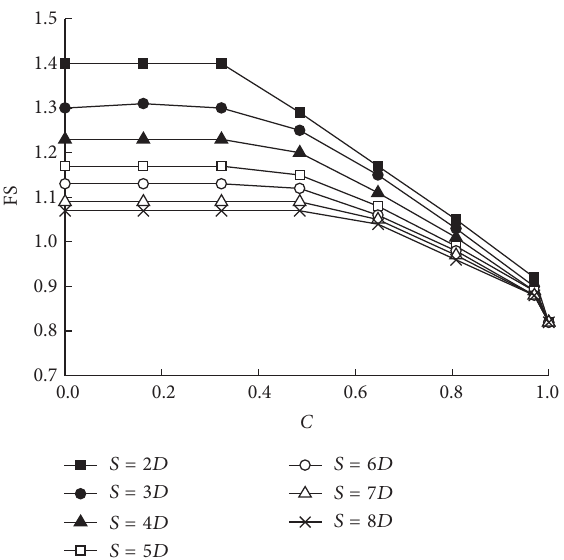
Figure 20: FS values of the piled slopes for Model B ( D = 0.8